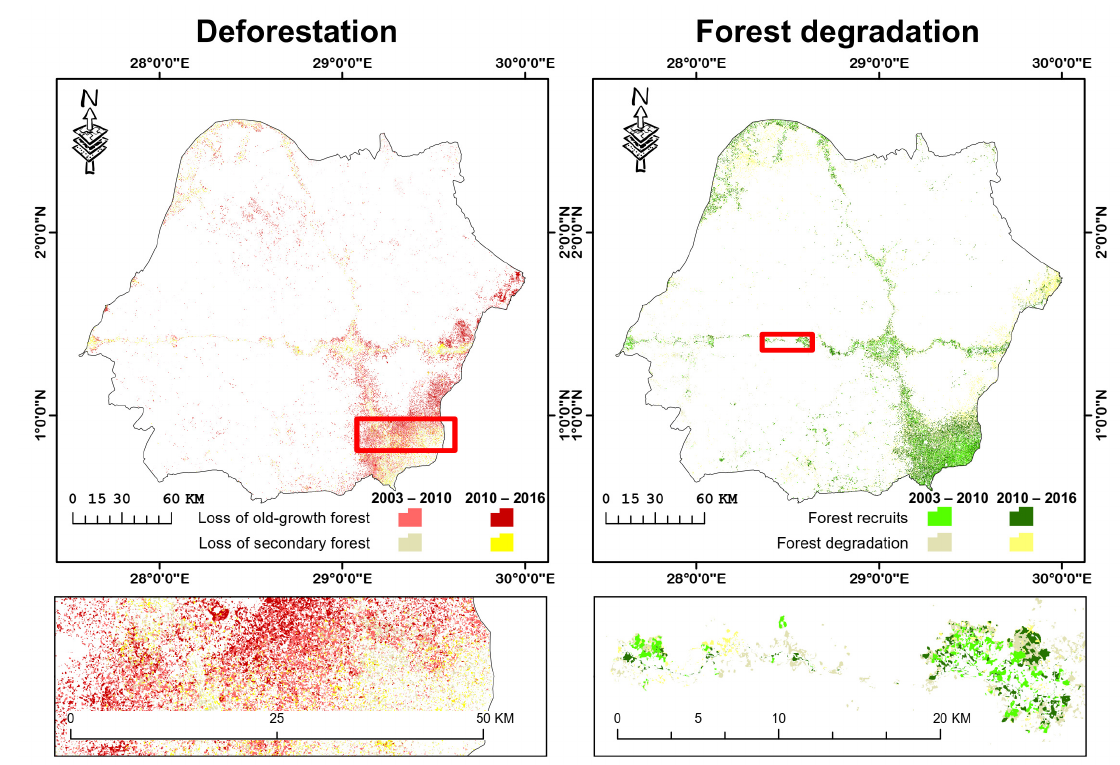
Figure 5. Mapping of forest cover changes: deforestation ( left ) and forest degradation ( right ).